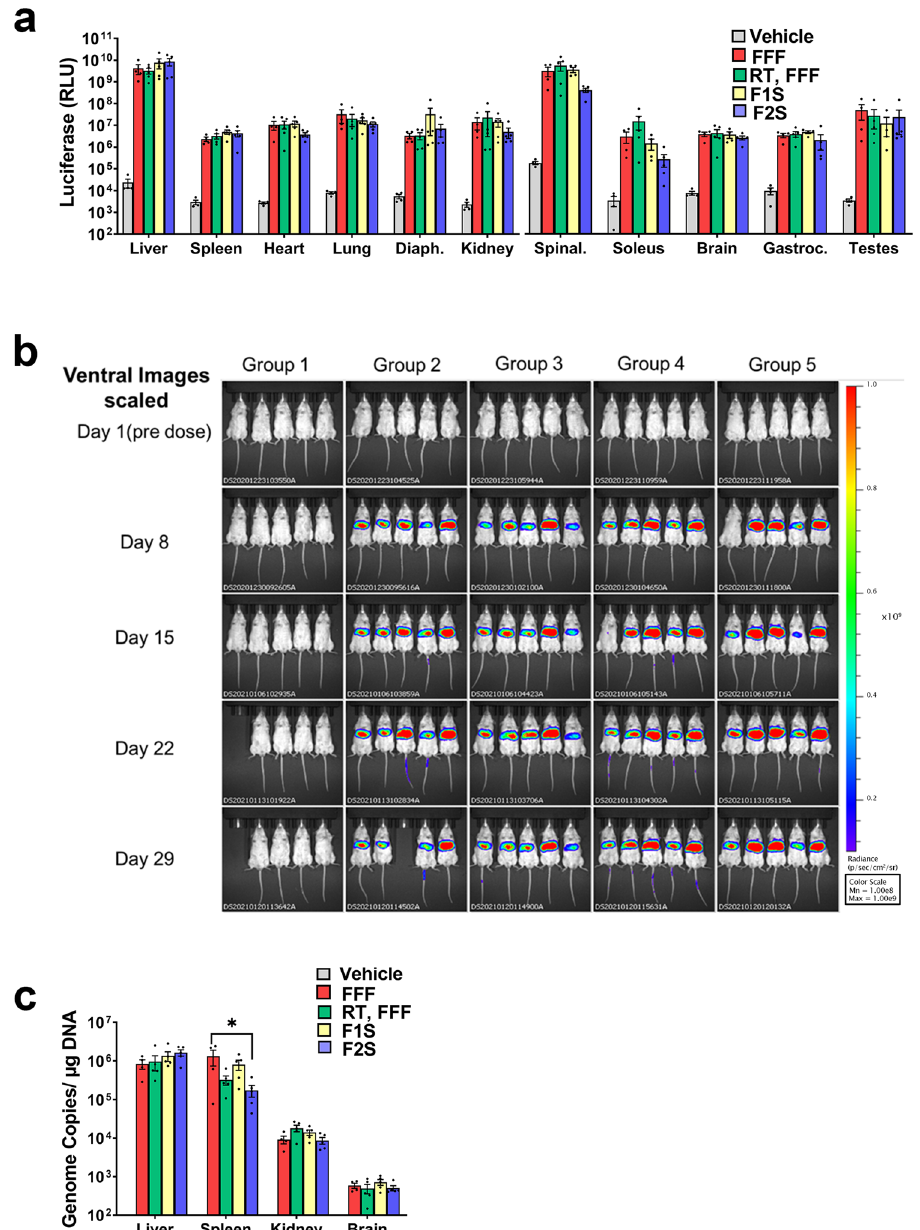
Fig. 6 In vivo performance of AAV stabilized in a thin fi lm for 30 days at 4 °C. Mice were given 1.5 × 10 11 virus genomes of formulated AAV9 CBA-Luc by tail vein injection. a Thirty days after administration, animals were sacri fi ced, organs harvested, and assessed for luciferase transgene expression with bioluminescence imaging. Mean (±standard error of the mean) values for total fl ux for each organ collected from fi ve mice per treatment group are shown. b Bioluminescent images of mice from each treatment group at 1, 8, 15, 22, and 29 days. Relative bioluminescence intensity is shown in pseudo-color, with red and blue representing the strongest and weakest photon fl uxes, respectively. NOTE: Two animals, one from the saline control group (Group 1) and that which was given freshly puri fi ed vector in the Standard Control Formulation (Group 2), were found deceased in their cages on day 22 and day 29, respectively, with no gross abnormalities observed externally nor internally upon visual inspection of the organs. These deaths were attributed to the blood collection technique that was used at the time. The procedure was immediately changed when these observations were noted so that all mice in the remaining treatment groups were able to complete the full course of the study. Treatment Groups: Group 1: Vehicle (saline control); Group 2: FFF, Group 3: RT, FFF, Group 4: F1S, Group 5: F2S. c Organs with high transgene expression were further analyzed for virus genome copies by quantitative real-time PCR. Data re fl ect the mean (±standard error of the mean) values obtained from tissues collected from fi ve mice per treatment group. Signi fi cant differences between animals treated with vectors in the standard control (FFF) and the F1S and F2S formulations were evaluated by one-way ANOVA with Dunnett ’ s multiple comparison tests. * p < 0.05. Abbreviations (Panels a and c ): Vehicle: saline control, FFF frozen standard control formulation, RT, FFF freshly puri fi ed vector in standard control formulation held at room temperature (RT) during the time needed for fi lm formation to be complete then refrozen, F1S high-viscosity fi lm formulation, F2S low-viscosity fi lm formulation, Diaph diaphragm, Spinal Spinal cord, Gastroc gastrocnemius muscle.